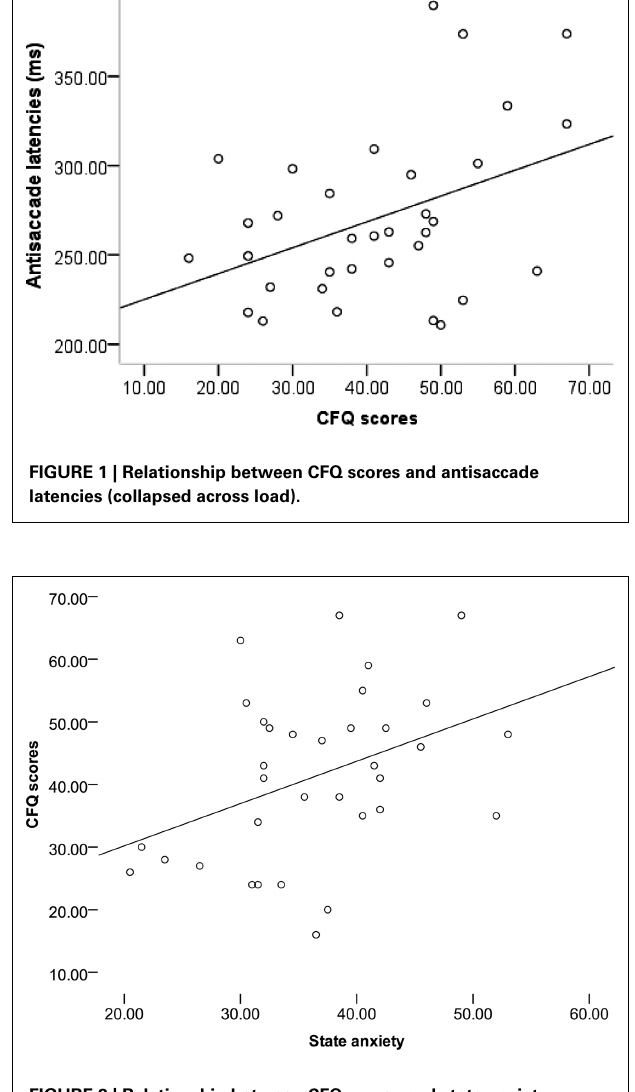
FIGURE 2 | Relationship between CFQ scores and state